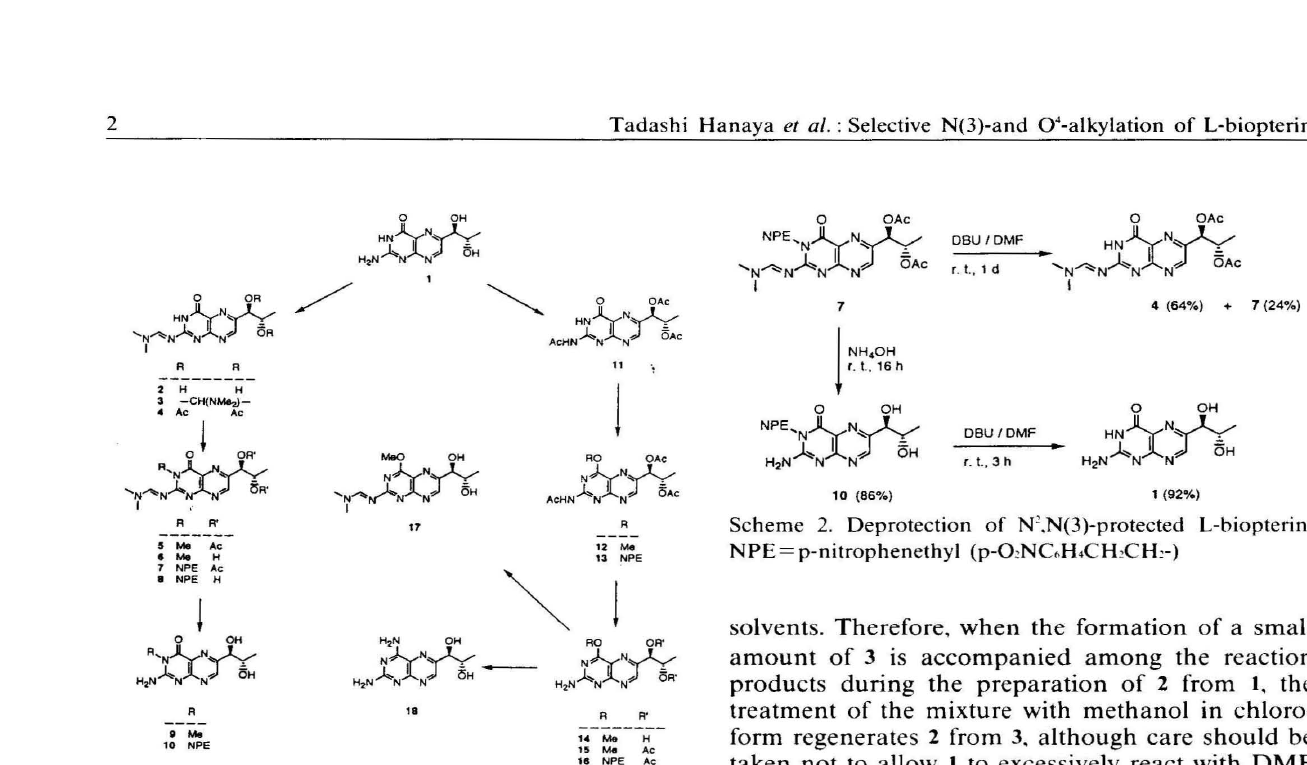
Scheme 2. Deprotection of N'.N(3)-protected